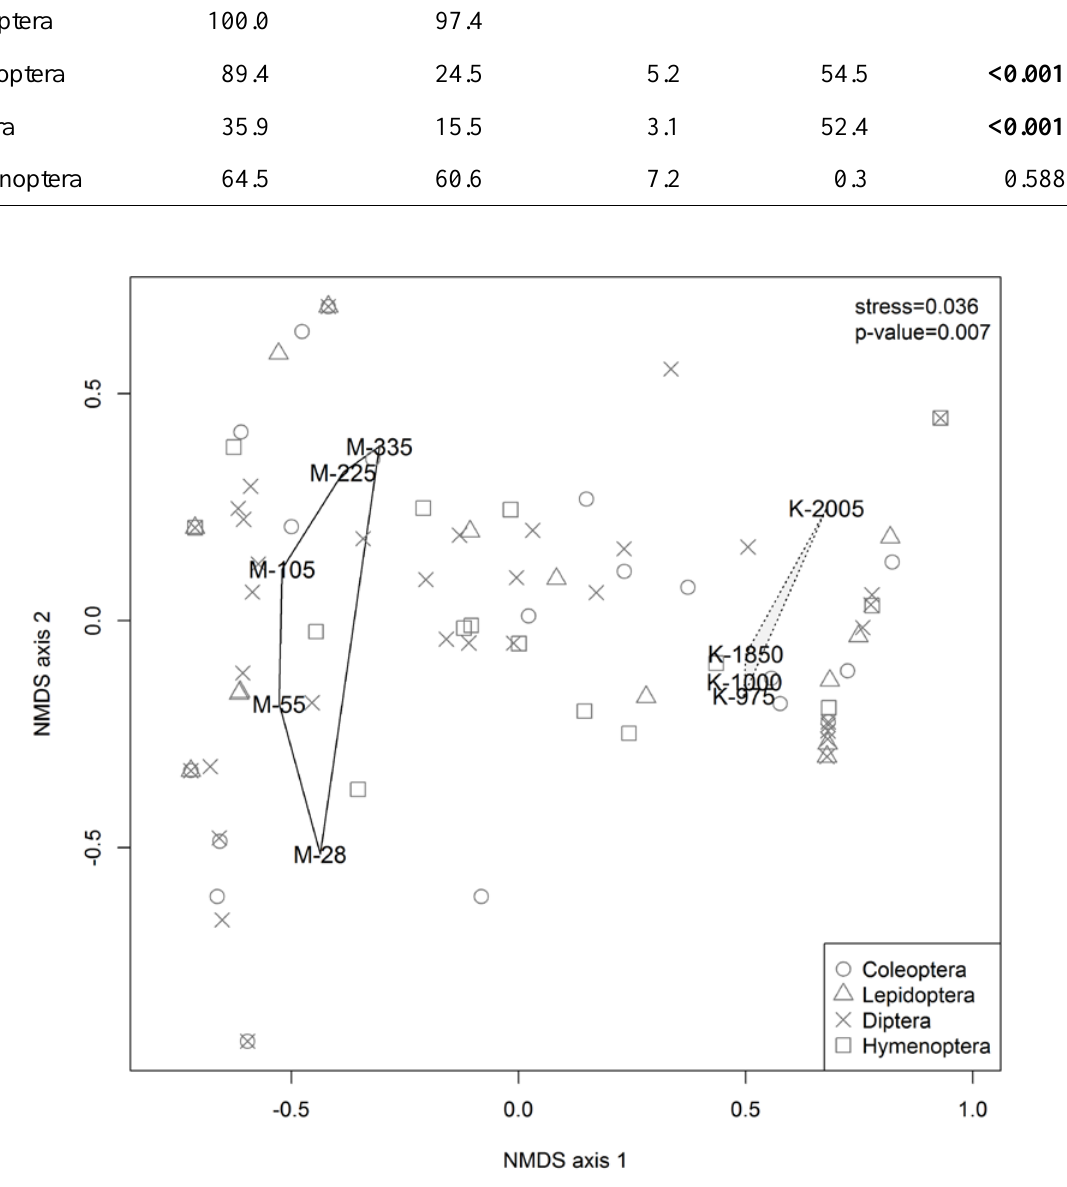
Figure 1. Non-metric multidimensional scaling (NMDS) ordination with the Bray-Curtis dissimilarity matrix between the square-root transformed total abundance of different Coleoptera, Lepidoptera, Diptera and Hymenoptera invertebrate species at four study plots within an intact raised peat bog (Kopuatai) and five study plots with a modified raised peat bog (Moanatuatua) in New Zealand. Scores for the Kopuatai plots are labelled ‘K’ and scores for Moanatuatua plots are labelled ‘M’. Numbers indicate distance (m) from the wetland edge. The lines represent the convex hull for the two bogs, dashed for Kopuatai and solid for Moanatuatua. The NMDS stress value and the p-value for a test of difference between the centroids for the two bogs are